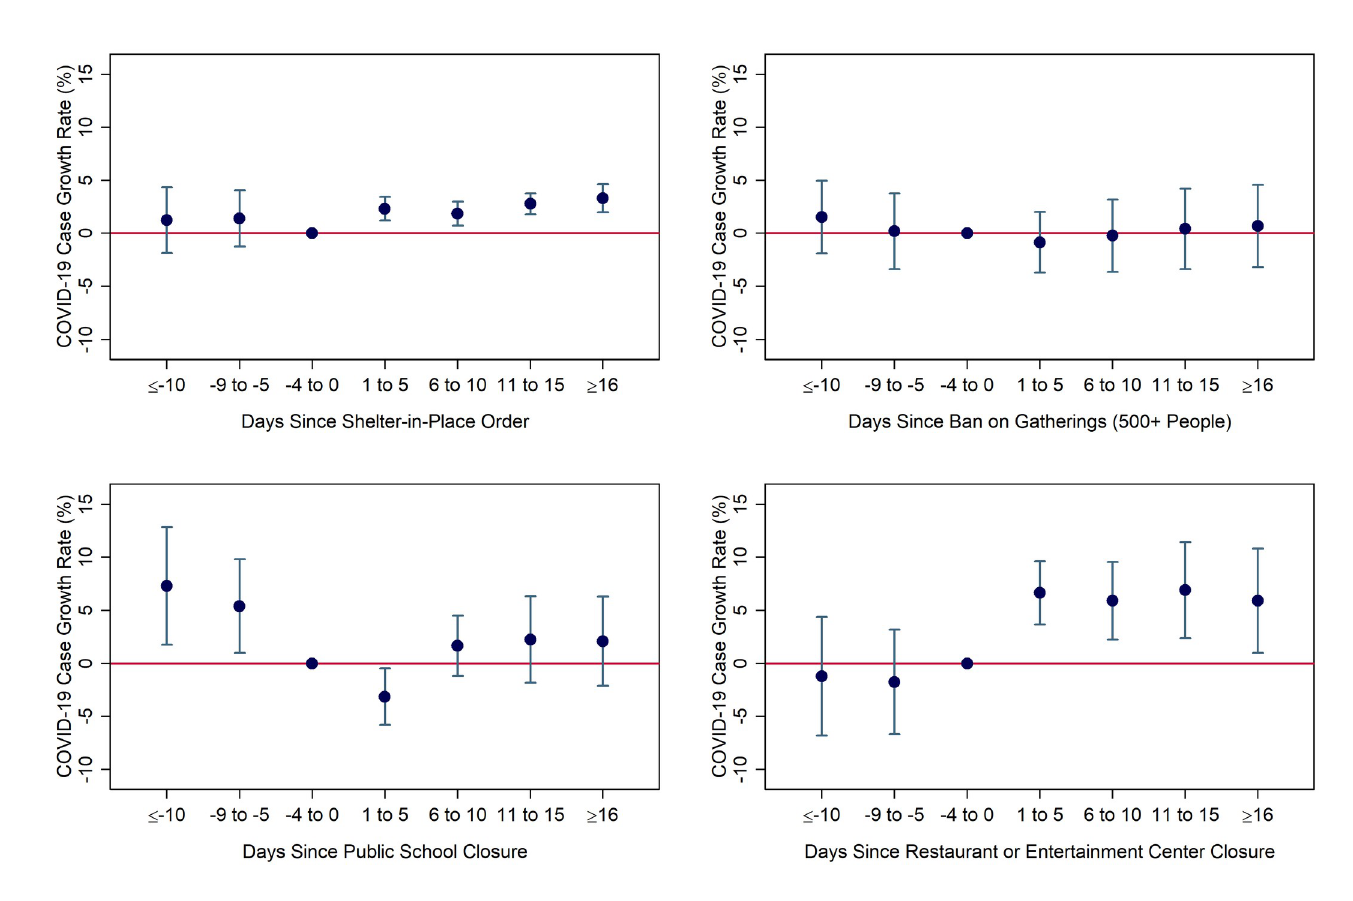
Fig 4. Coefficient estimates for interactions of the “white working class” index with social-distancing measures. Notes: Coefficients and 95% confidence intervals were derived from authors’ event-study regression using daily county-level data from March 5-April 25 from the South and Midwest Census Regions, weighted by population. Day and county fixed effects were included. Standard errors were heteroskedasticity-robust and clustered by state. Specifications include interactions between regulations indicators and the “white working-class” index